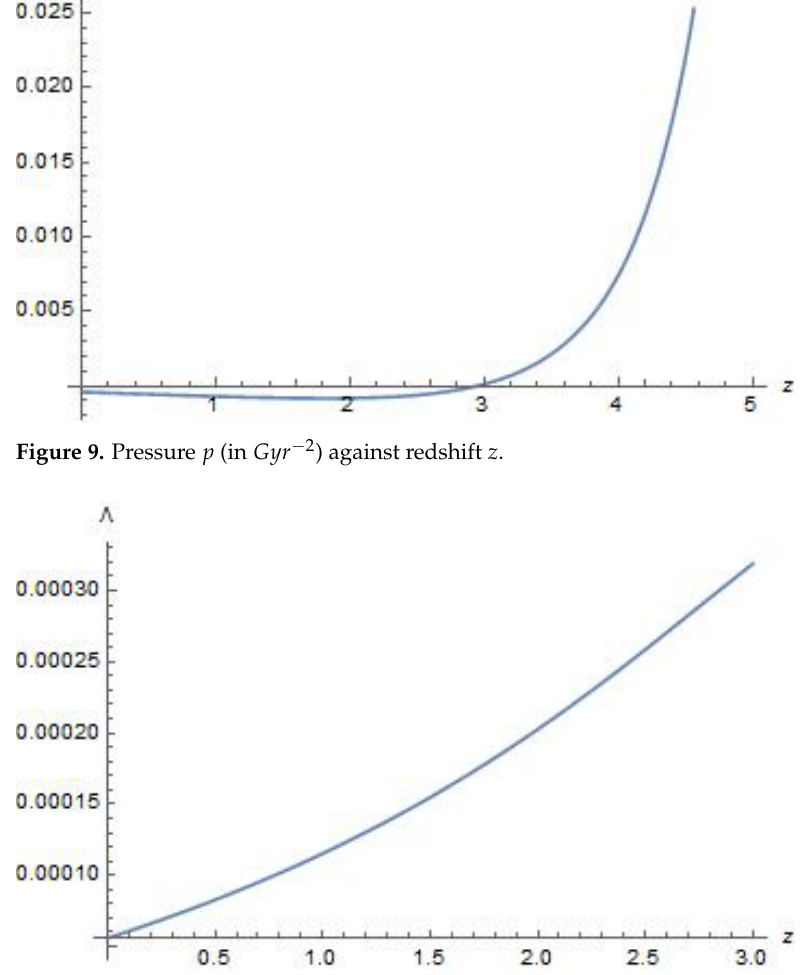
Figure 10. Cosmological parameter Λ (in Gyr − 2 ) against redshift z .